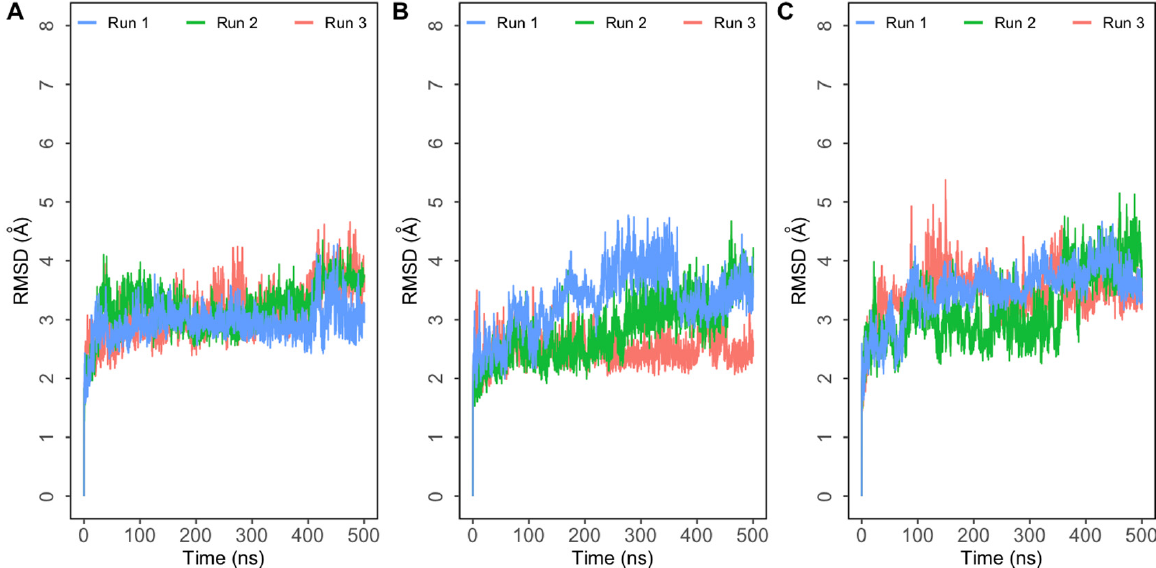
Figure 2. Root mean square deviation (RMSD) of protein backbone atoms with respect to the initial structure obtained from three independent 500 ns simulations of SARS-CoV-2 spike (S) protein bound to human ACE2 (hACE2). ( A ) Simulations of double mutant E484Q + L452R complex; ( B ) simulations of E484Q complex; ( C ) simulations of L452R complex.